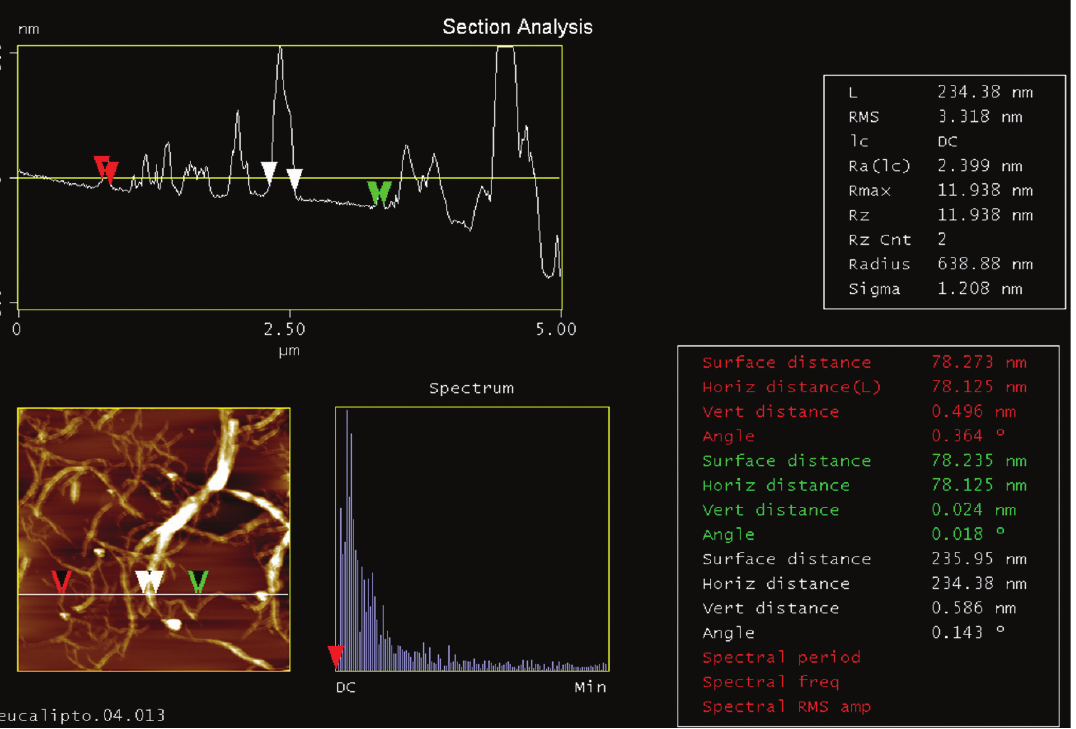
Figure 2. Microfibril profiles by AMF with diameter varying from 78 to 235 nm.